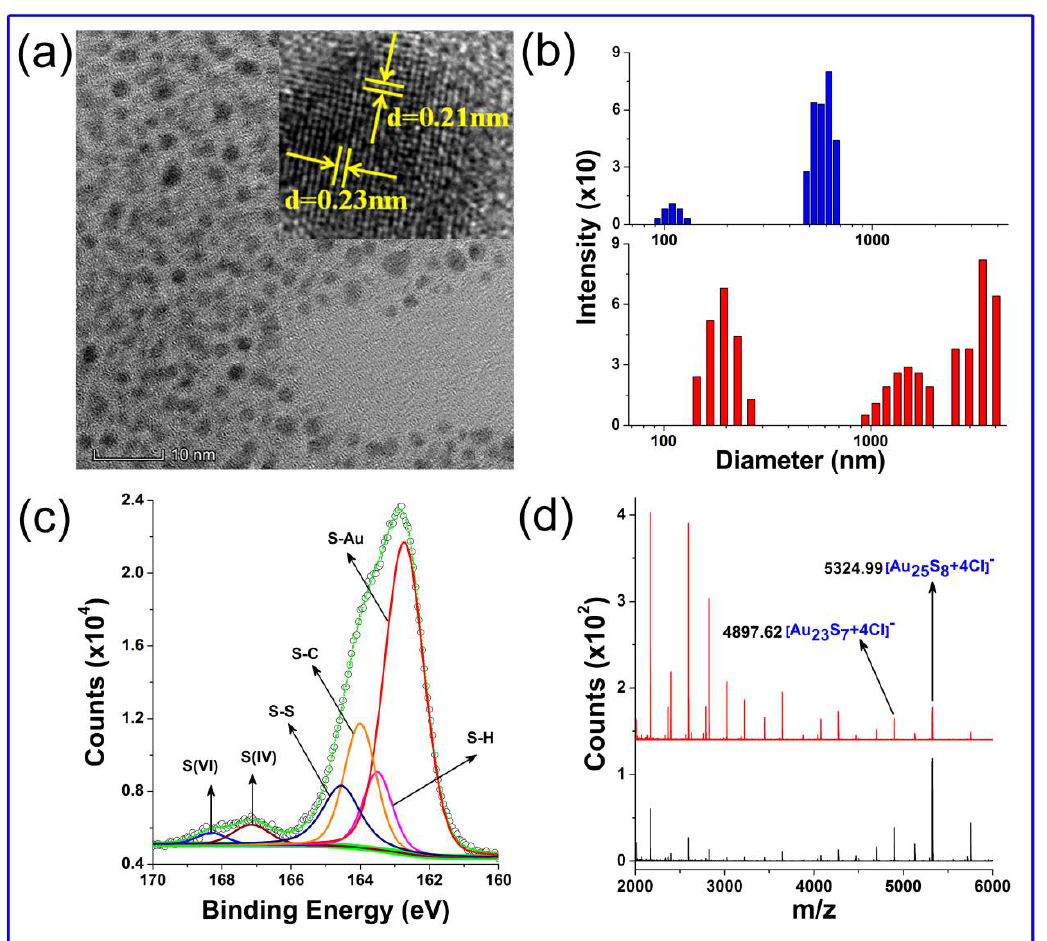
Figure 3. ( a ) HR-TEM image of the GSSG–AuNCs (inset shows the lattice fringe of the nanoclusters). ( b ) DLS spectra of GSH–AuNCs (upper) and GSSG–AuNCs (bottom). ( c ) XPS spectrum of S 2p of GSSG–AuNCs. Peak identities: 168.2 eV, oxidized sulfur, S (VI); 167.1 eV, oxidized sulfur, S (IV); 164.5 eV, disulfide bond, S–S; 164.0 eV, sulfur–carbon bond, S–C; 163.5 eV, sulfur–hydrogen bond, S–H; 162.8 eV, sulfur–gold bond, S–Au. ( d ) MALDI-TOF mass spectra of GSSG–AuNCs (upper) and GSH–AuNCs (bottom).